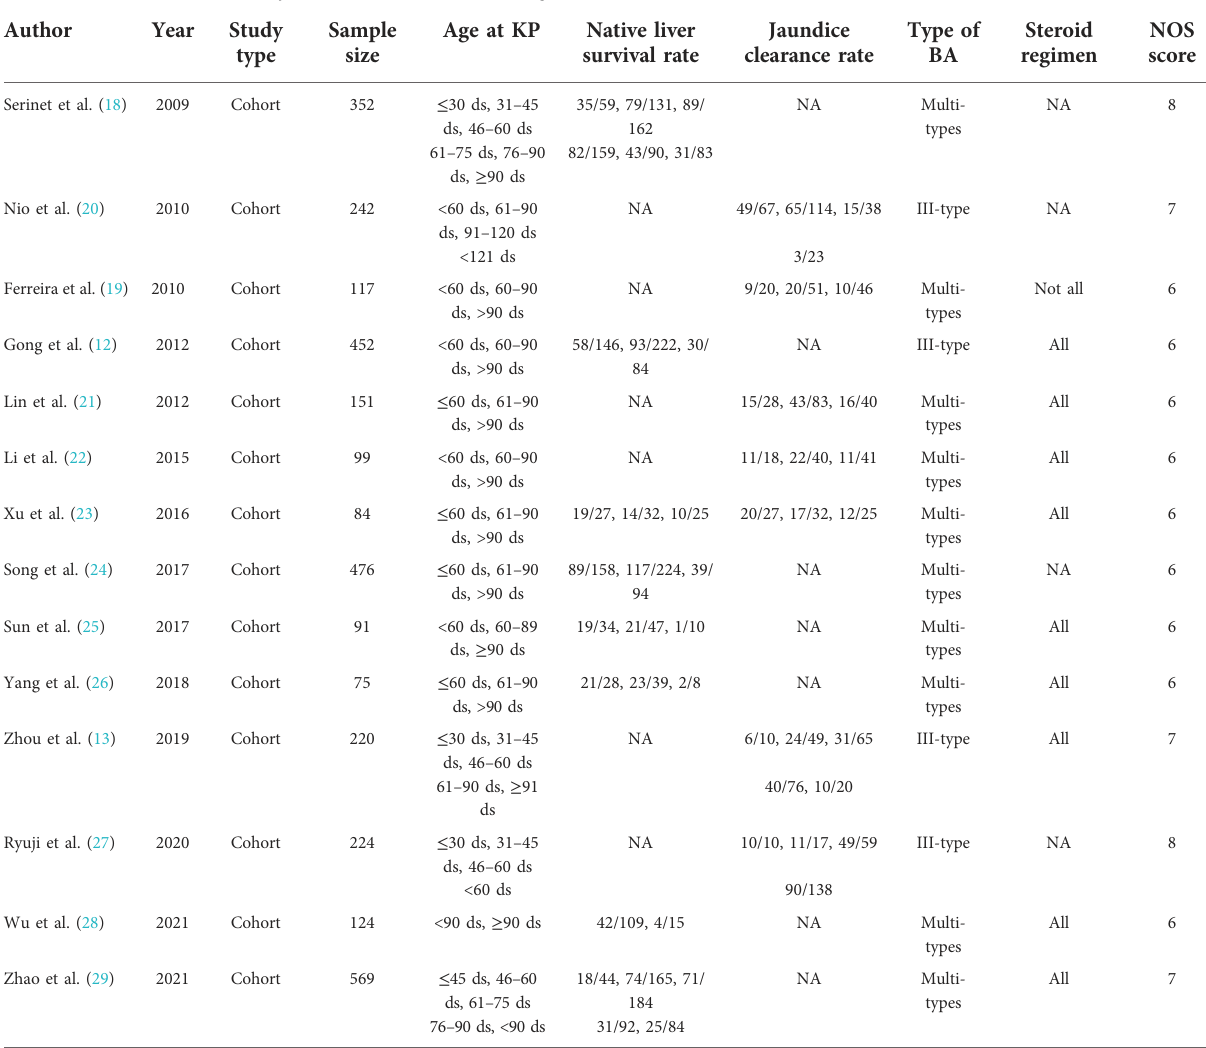
TABLE 1 Characteristics of the reports included in the